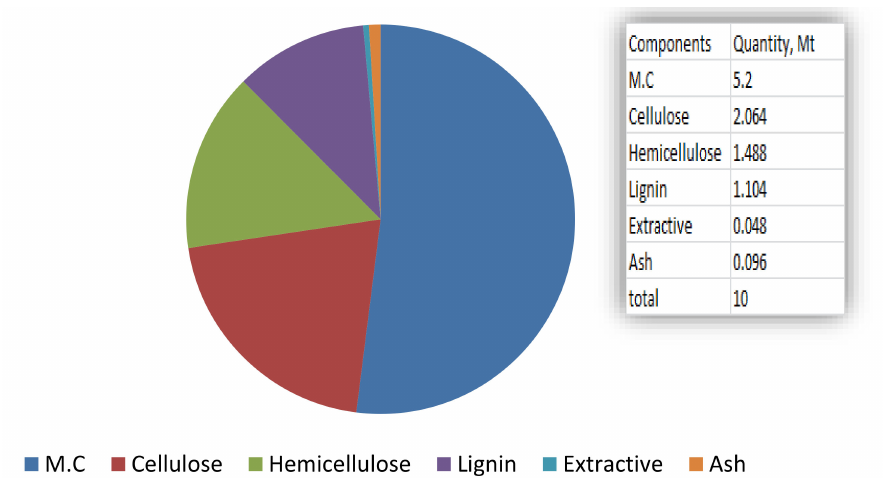
Figure 2. Quantity of each component in bagasse (Mt) in Australia.